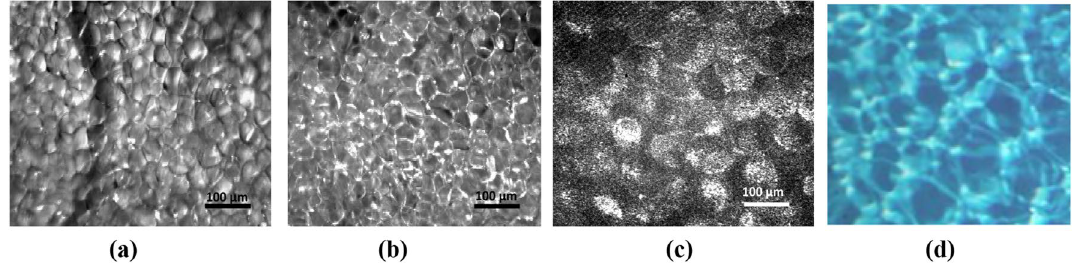
Figure 1. In vivo microscopic images of fat tissue of a rat at back reflectance from a few millimeters of an intact abdominal fat layer using a CMOS camera: a white light source ( a ); green LED 517 nm ( b ); He–Ne laser 632.8 nm ( c ); the light breeze on the shallow seawater on a sunny day ( d ) (see Supporting Information); see the similarity of caustics formation due to focusing of shining light by a lens let array of these complex systems with shape variation in a semiregular manner, due to which phase is different from the out-of-water